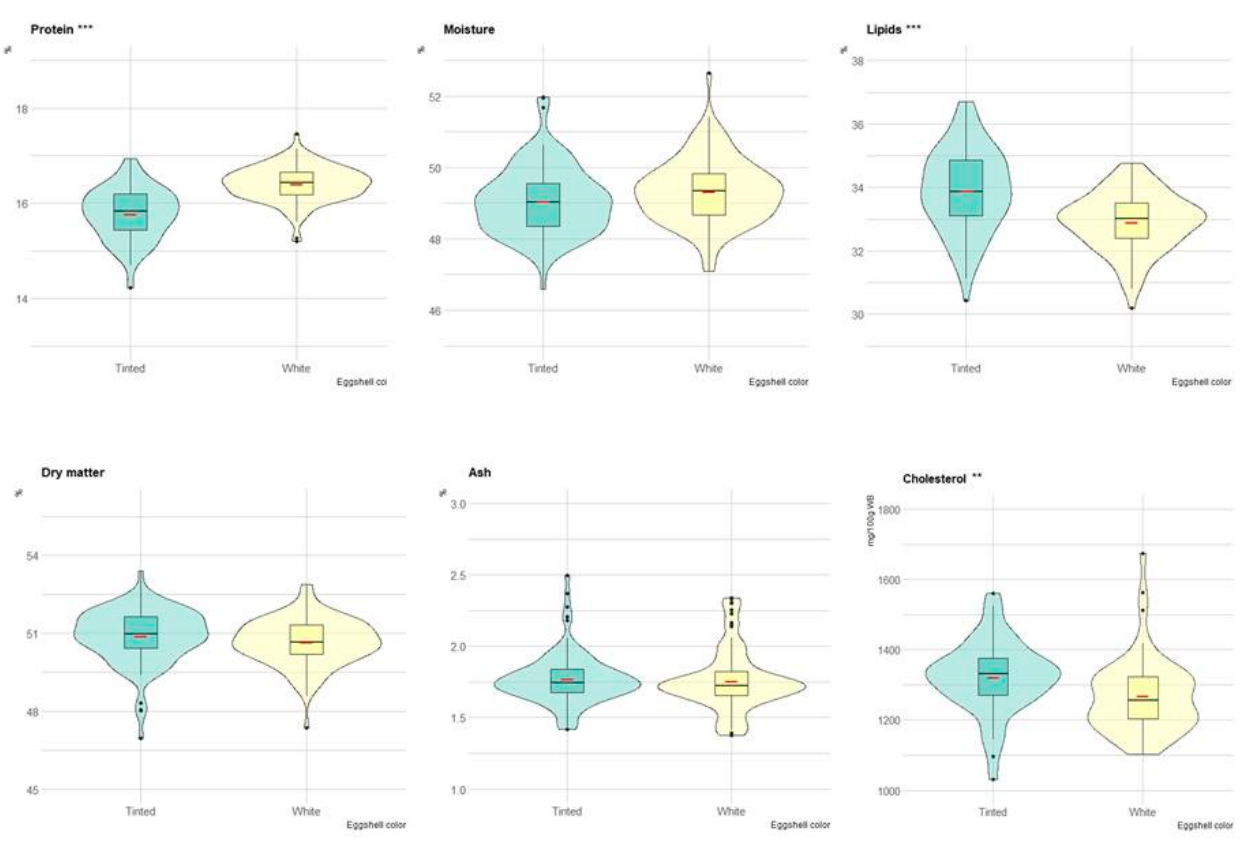
Figure 3. Boxplot of the composition (on a wet basis) of yolk in eggs of tinted (violet) and white (yellow) shell. Red dash indicates mean value. The violin blot represents the data distribution. ** p < 0.01; *** p < 0.001.